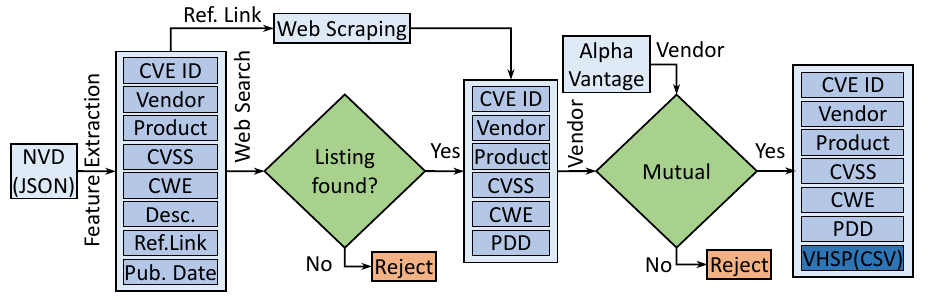
Figure 1. Dataset Creation Flow. Desc. is vulnerability description, Ref. Link is the link referring to vulnerability details, Pub. Date is the Published Date, CVSS is Common Vulnerability Scoring System metrics, CWE is the Common Weakness Enumeration identifier, PDD is the Public Disclosure Date, and VHSP is the Vendor Historical Stock Price downloaded of mutual vendors from Yahoo